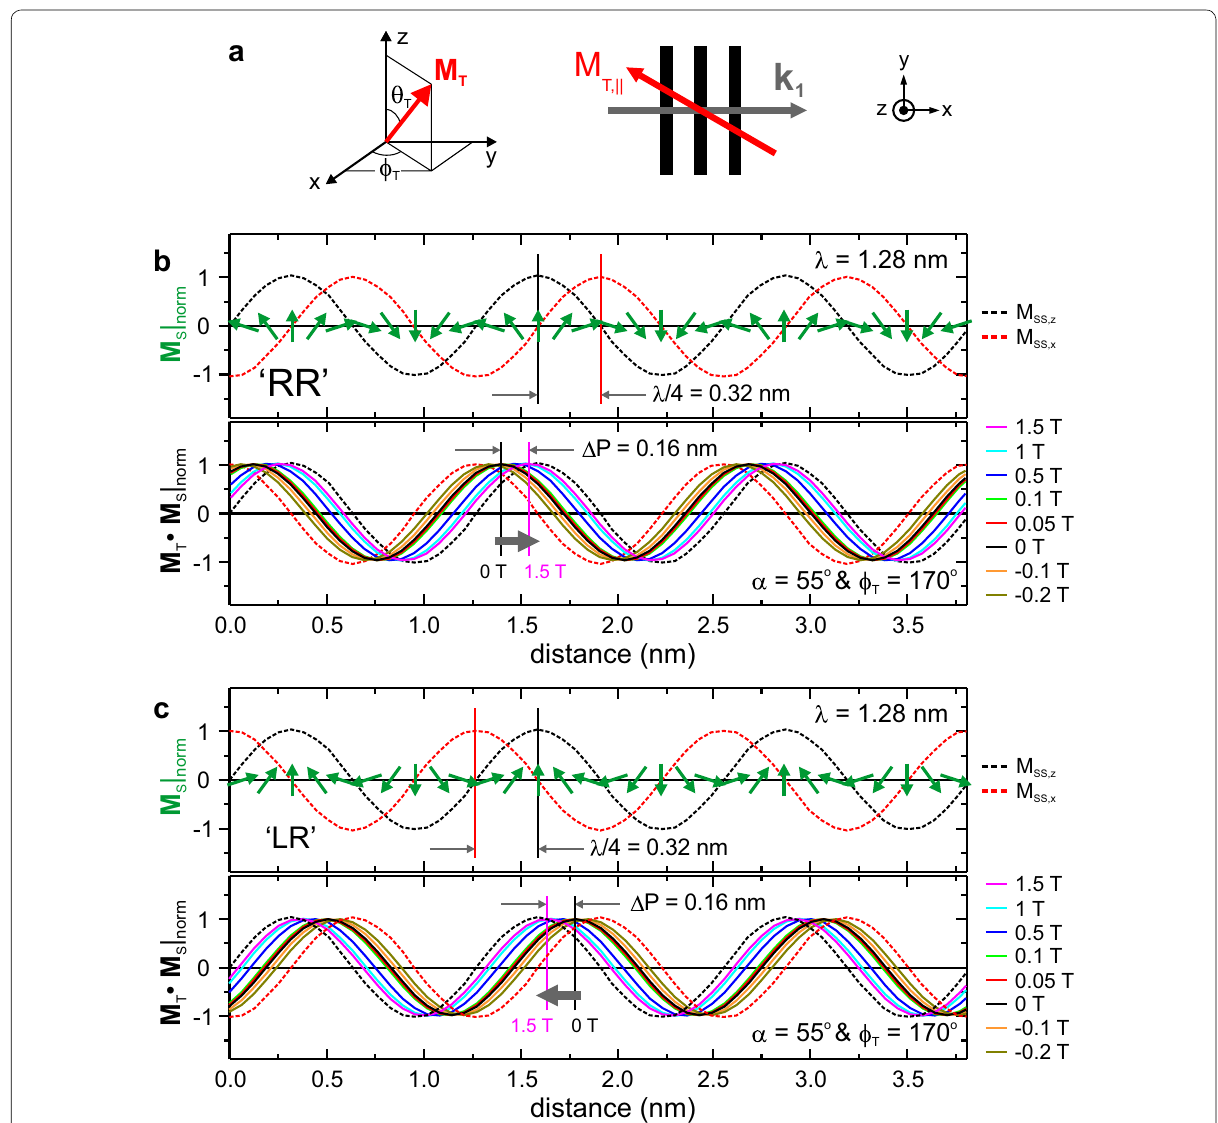
Fig. 9 Probing non‑collinear cycloidal spin order with a field‑tuned tip with Stoner‑Wohlfarth magnetization behavior. a A description of the tip magnetization M T of a “Stoner‑Wohlfarth tip”, with the polar ( θ T ) and azimuthal ( φ T ) angles, in the Cartesian coordinate system and a sketch of the geometric relation between the in‑plane component of the tip magnetization M T , and the wave vector k 1 of the stripe pattern for the region 1 in Fig. 8 c . The black bars indicate the stripe pattern. b , c The upper figure of b ( c ) shows the x ‑position dependence of out‑of‑plane and in‑plane com‑ ponents of local magnetization of the RR‑ (LR‑) order. The lower figure of b ( c ) shows the field dependence of the M T · M S | norm curves as a function of the position x , calculated with θ T 55° and φ T 170° for a RR‑ (LR‑) order. The in‑plane ( red dotted ) and out‑of‑plane ( black dotted ) components = = of the spin cycloidal order are shown in the coordinate system illustrated in a . The green arrows in the upper figure of b ( c ) indicate the local magnetization variation in space for a RR‑ (LR‑) order. Reprinted from [7] with permission from Nature Publishing Group (Copyright 2014) (Reprinted from [7] with permission from Nature Publishing Group (Copyright